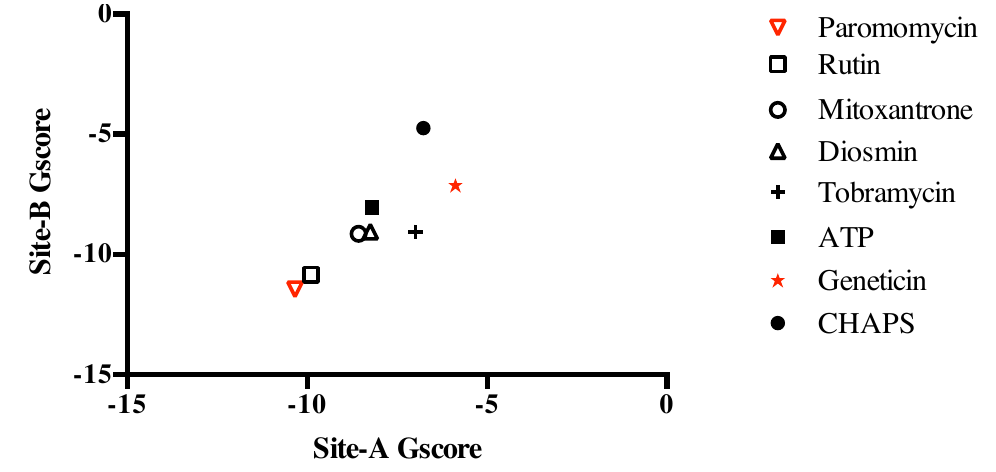
Figure 8. Site A and Site B docking scores. The top-ranked molecules resulting from docking to Site B were also employed to predict their docking scores to Site A. Additionally, CHAPS (present in the co-crystal structure) and ATP (co-factor) were also included in the analysis. The predicted GlideScores (kcal / mol) for each molecule are represented on the X -axis for Site A and on the Y -axis for Site